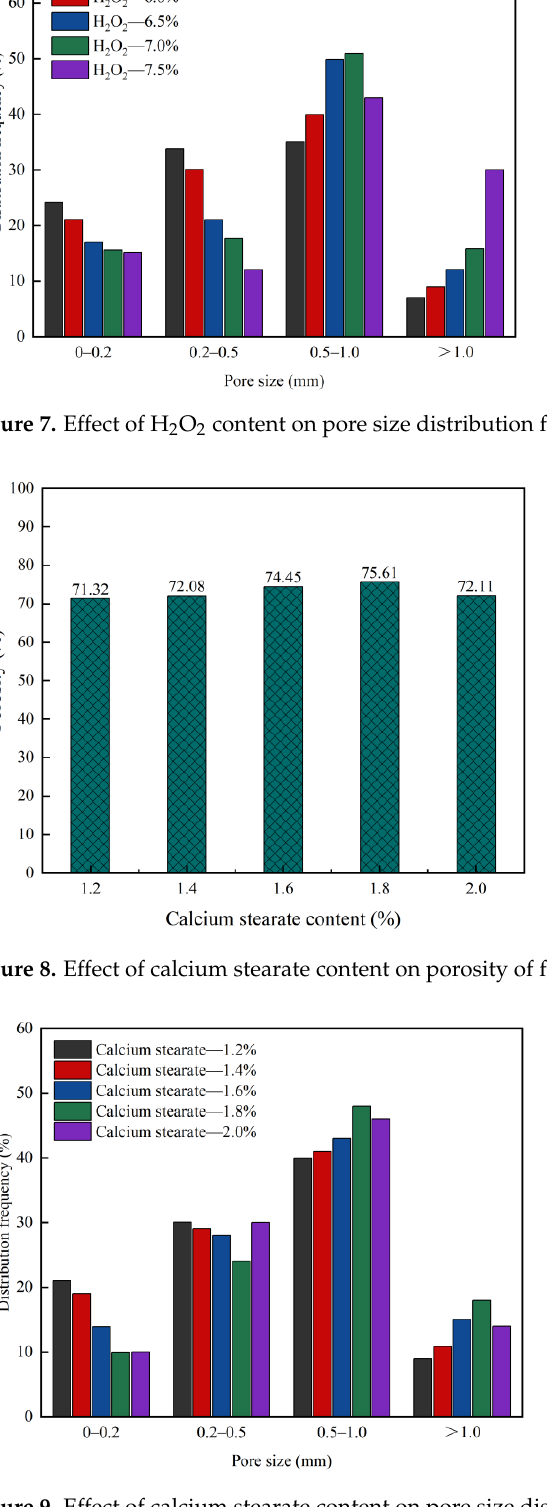
Figure 9. Effect of calcium stearate content on pore size distribution frequency of foam concrete.